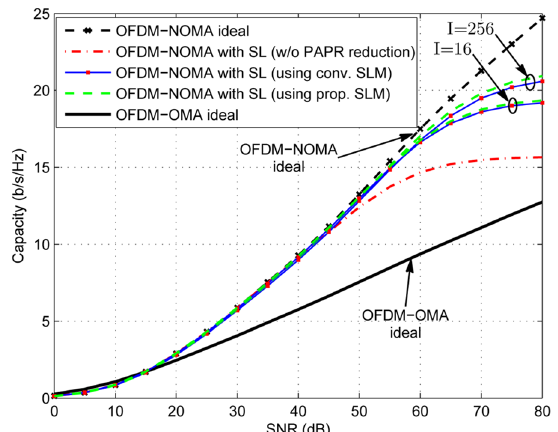
Fig. 6 Sum rate capacity of DL OFDM-NOMA in the presence of nonlinear distortion before and after using conventional and proposed SLM techniques, with different numbers of alternatives I = 64 and I = 256 , compared with the sum rate capacity of DL OFDM-NOMA and DL OFDM-OMA in ideal